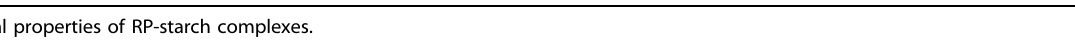
Table 2. Thermal properties of RP-starch complexes. Addition